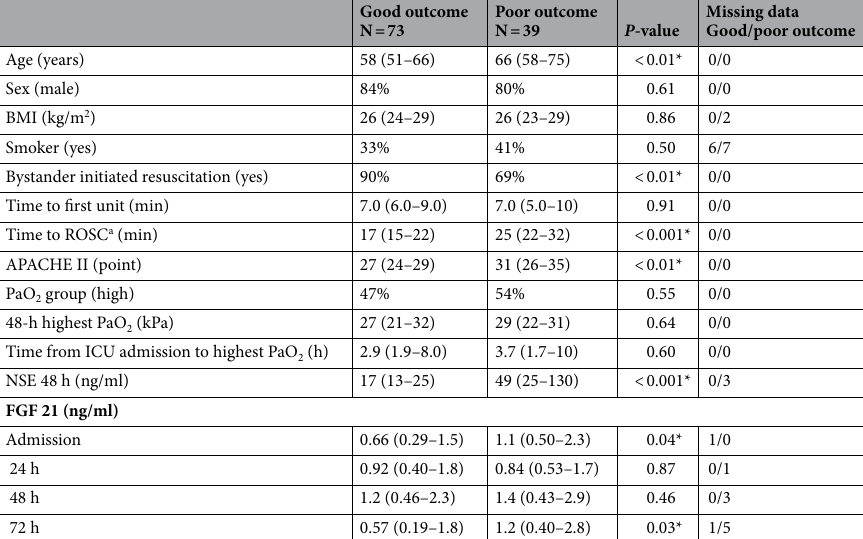
Table 1. Characteristics of the study patients (N = 112). Continuous variables: median (IQR), Mann Whitney U test; categorical variables: percentage of the whole, Fisher’s Exact test. Good outcome, 6-month